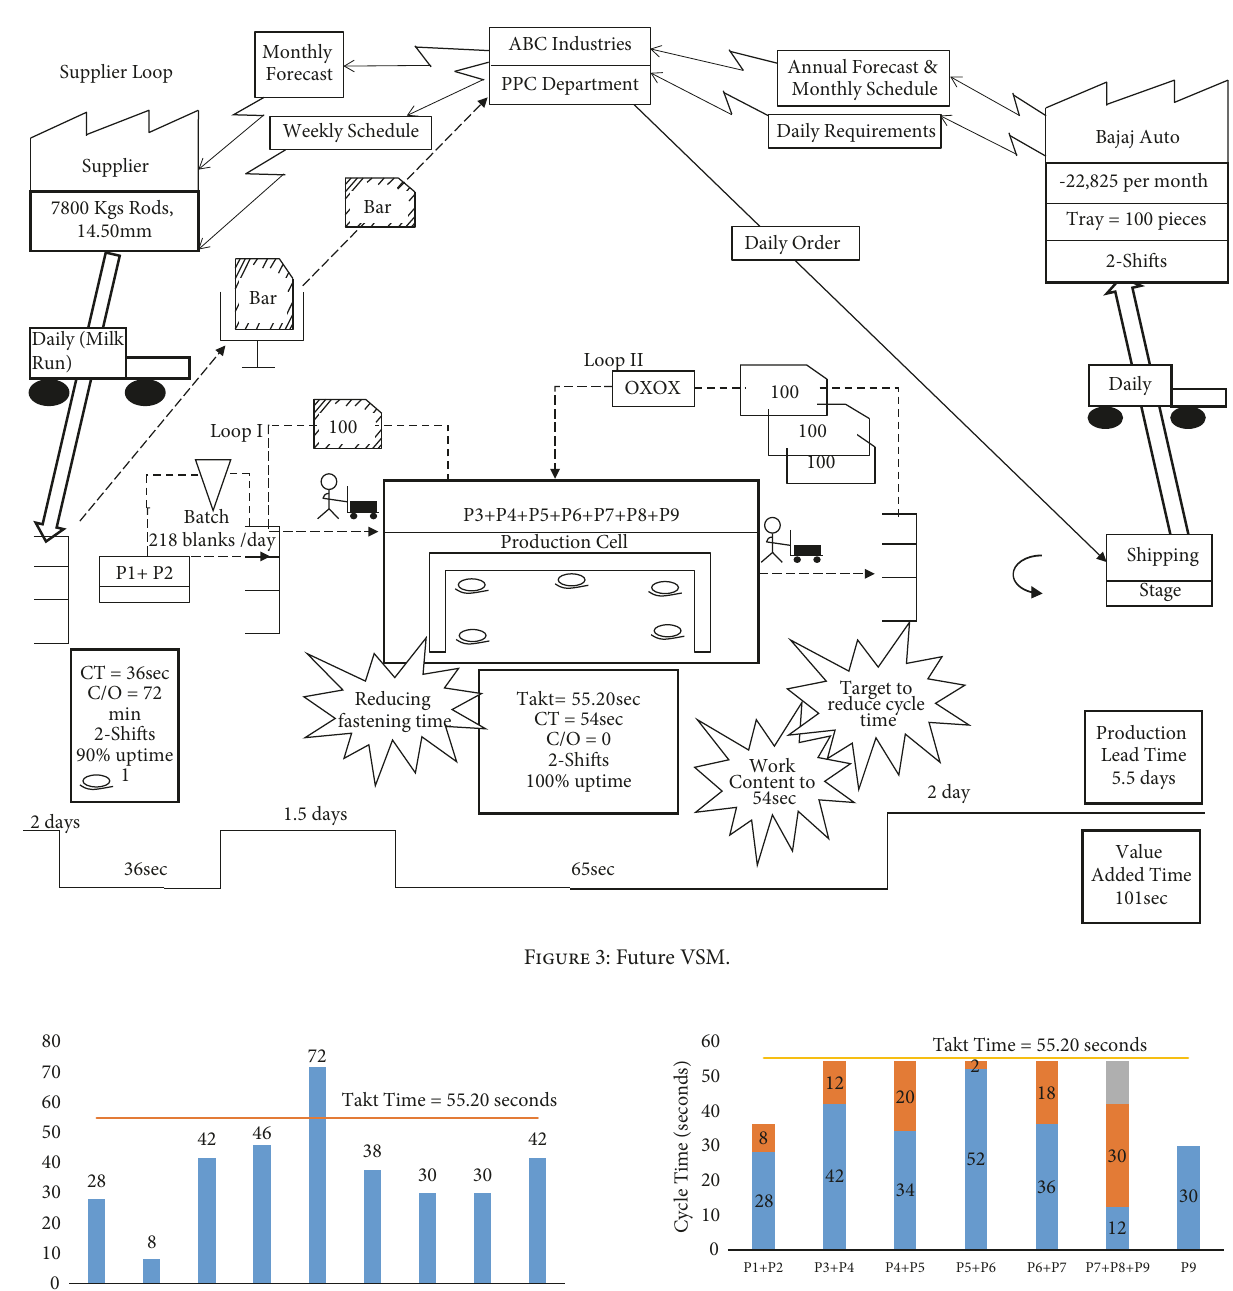
Figure 5: Cycle time with continuous